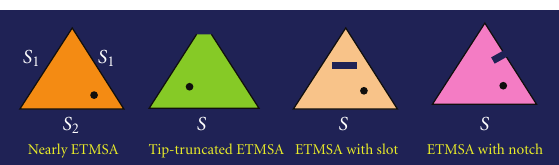
Figure 2: Methods obtaining circular